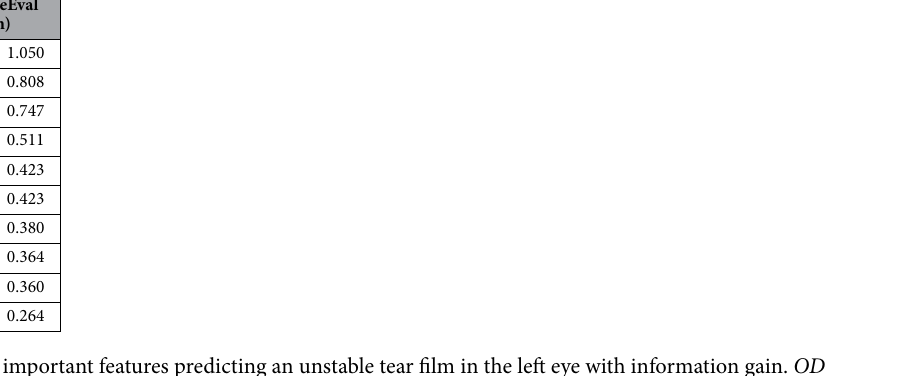
Table 6. Most important features predicting an unstable tear film in the left eye with information gain. OD right eye, OS left eye, ST Schirmer test, MQ meibum quality, OSDI ocular surface disease index, Blinkfreq blink frequency, OSS ocular surface staining, Osm